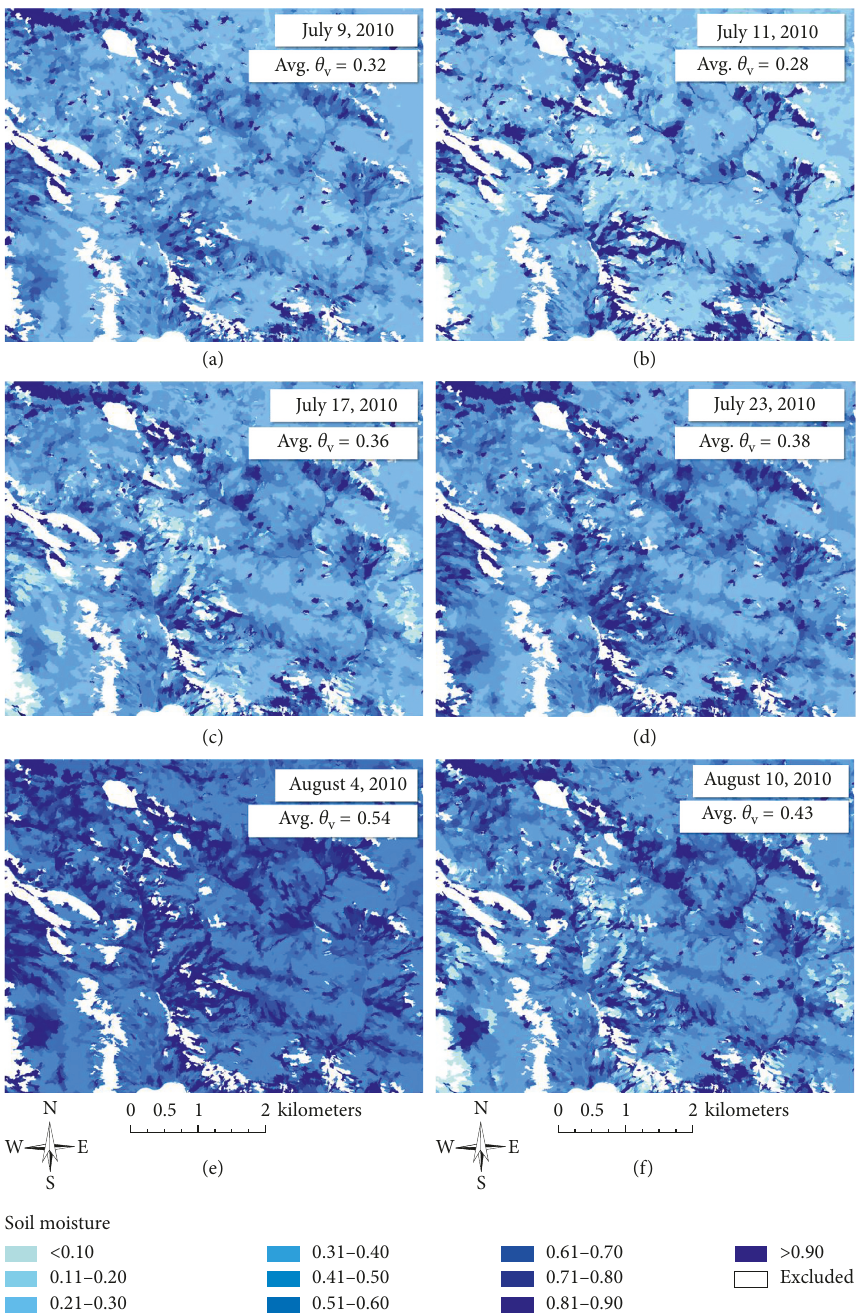
Figure 9: Spatiotemporal distribution of θ v across 6 dates in 2010 at the Cape Bounty Arctic Watershed Observatory. Average θ v values are the ANN-modelled averages for the field-measured